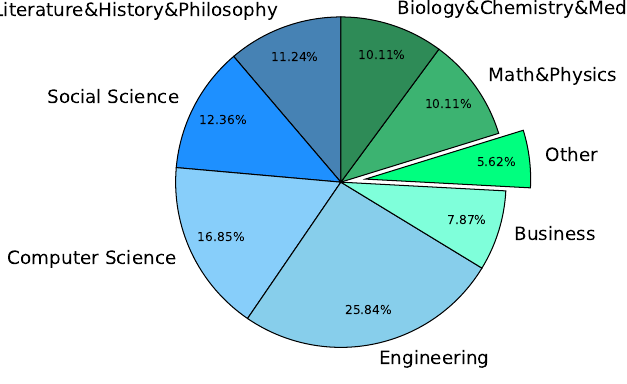
Figure 2. Courses across